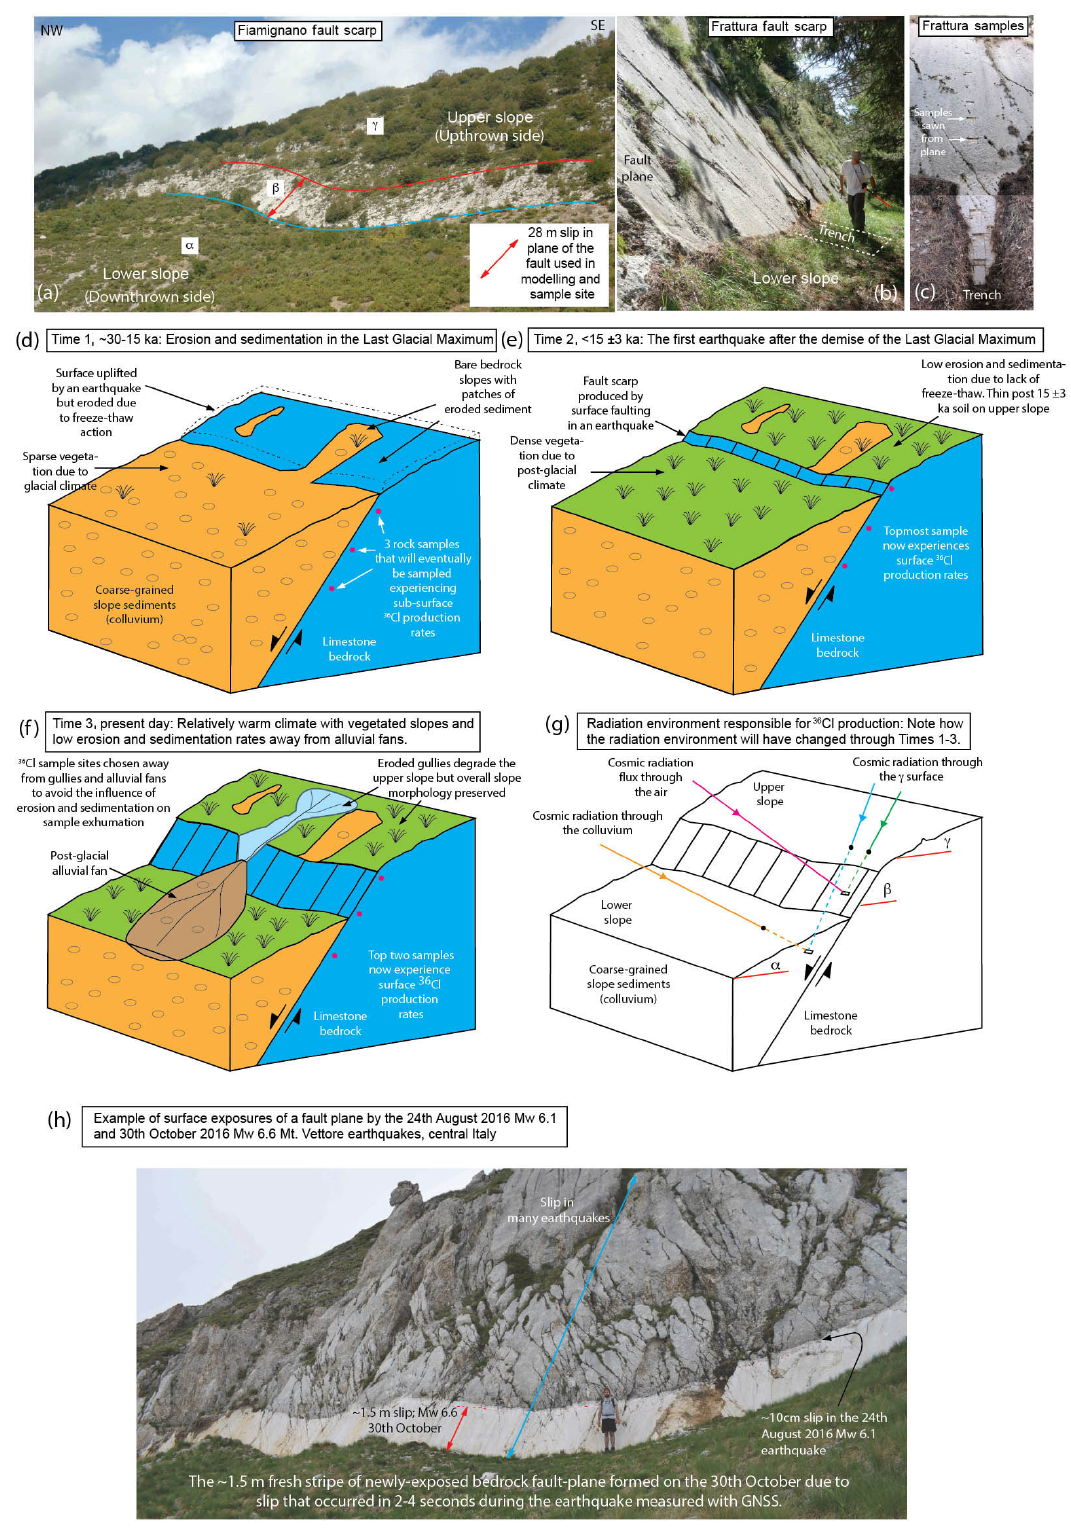
Figure 1. Images and illustrations of scarp evolution and radiation